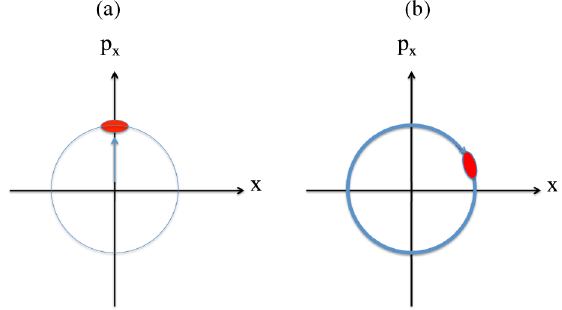
FIG. 3. In an arc with zero chromaticity, a transverse- momentum kick received from the linac (a), will translate (after rotation in the phase space) into a displacement of the entire bunch at the exit of the transport channel (arc) (b).